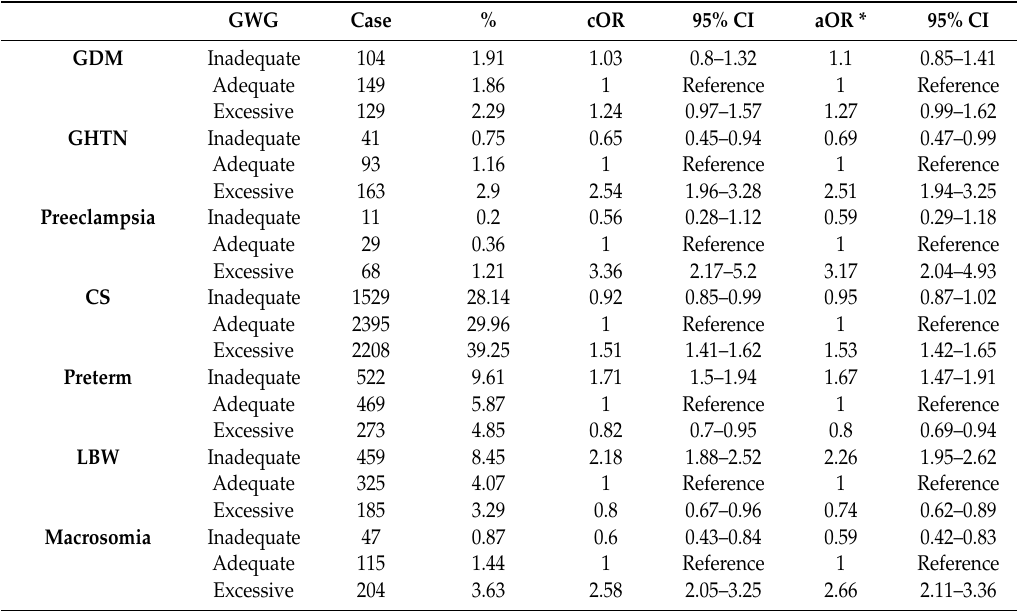
Table 3. Association between perinatal outcomes and gestational weight gain.